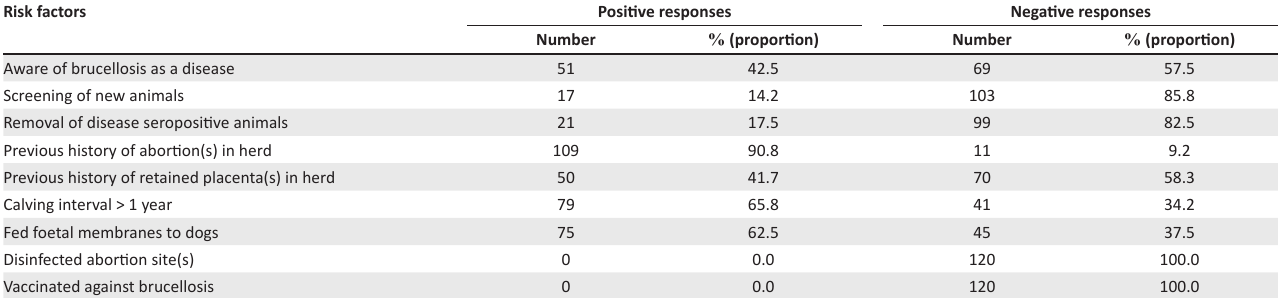
TABLE 1: The proportional responses of respondents ( n = 120) to questions addressing management-related risk